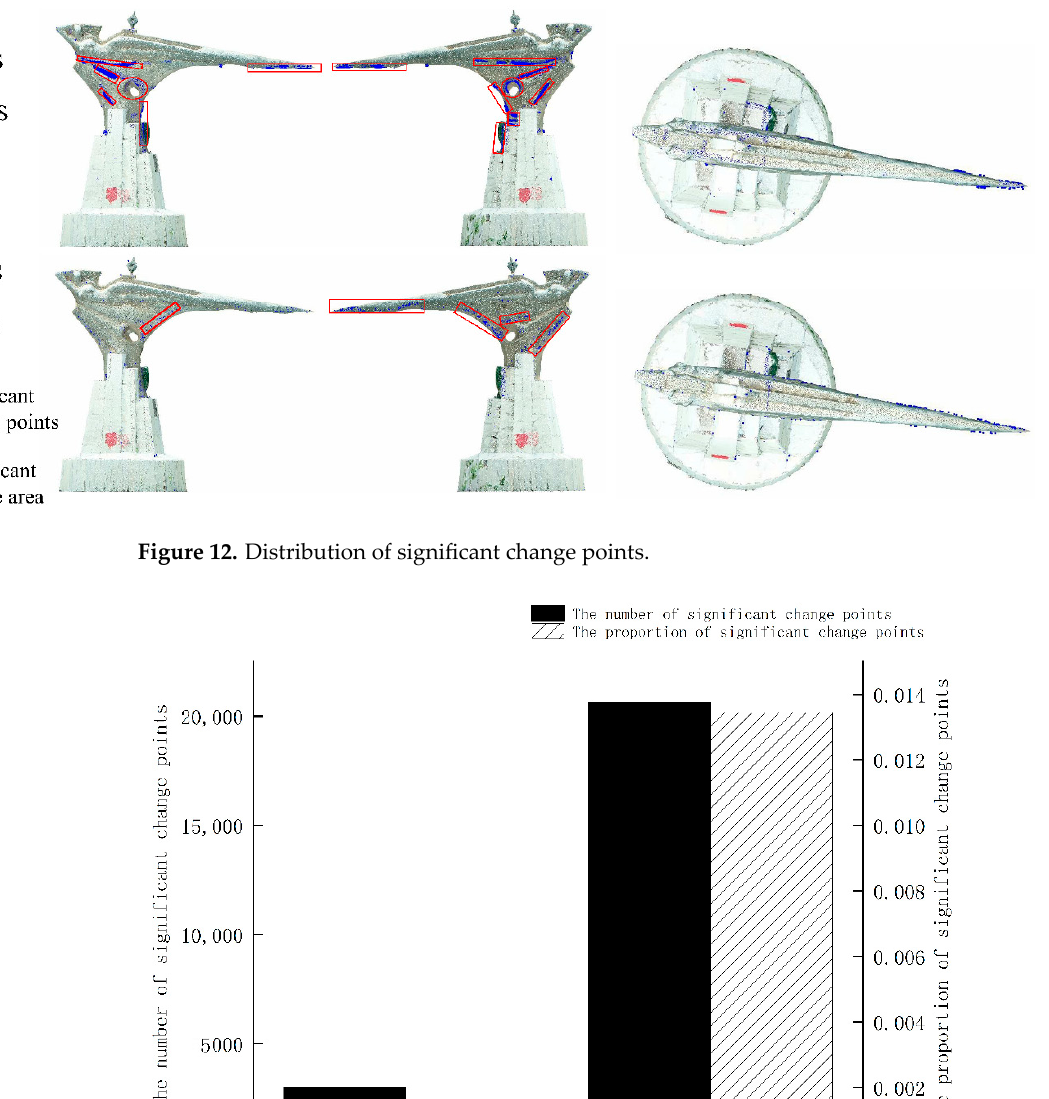
Figure 13. Statistics on the number and proportion of significant change points.